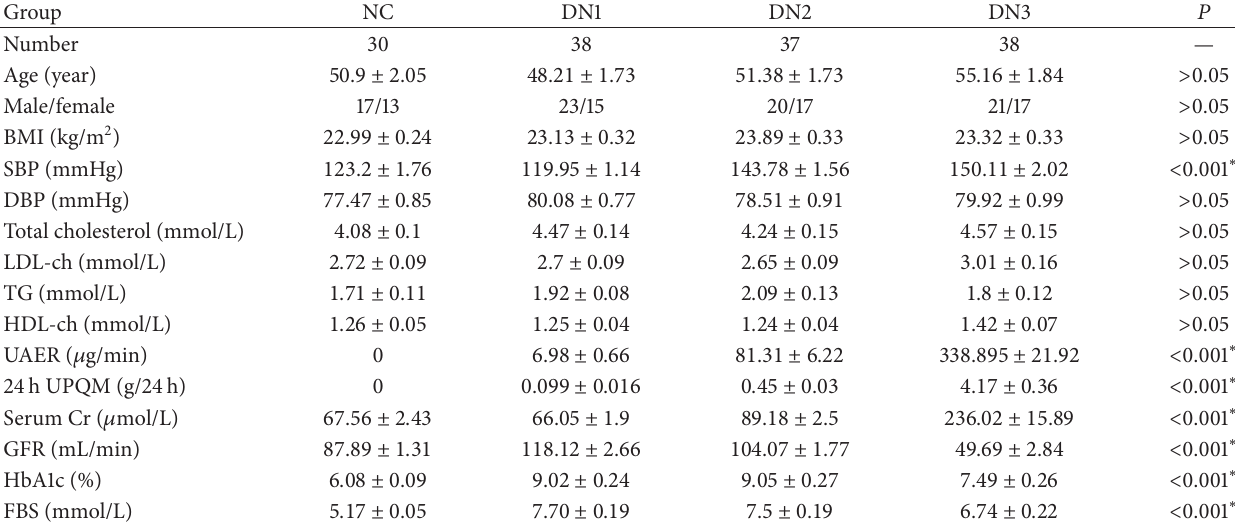
Table 1: Clinical and laboratory